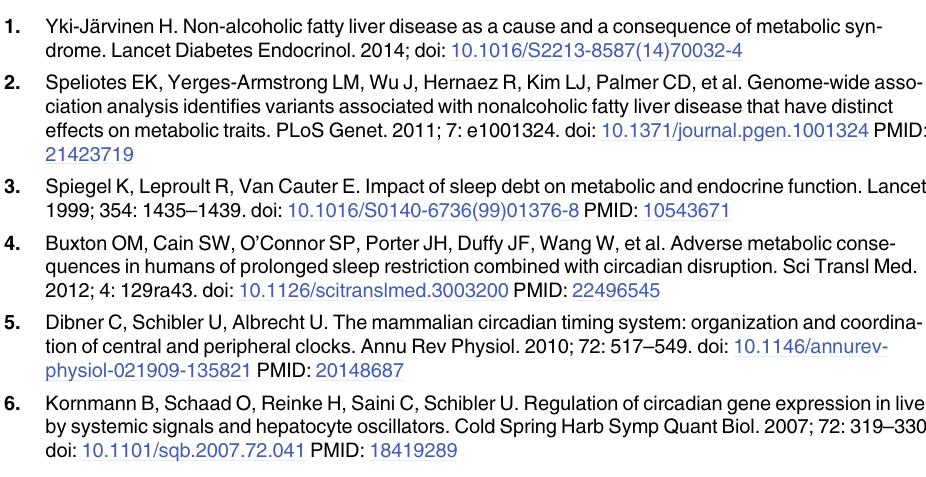
S2 Table. Biochemical parameters of Non-alcoholic fatty liver disease (NAFLD) patients and controls excluding subjects aged > 66 years. NAFLD patients n = 37 and controls n = 22. S3 Table. Sleep characteristics in patients with Non-alcoholic fatty liver disease (NAFLD) and controls excluding subjects aged > 66 years. NAFLD n = 37 (simple steatosis n = 11; NASH n = 26) and controls n = 22. Hours (h). Minutes (min.). Munich Chronotype Question- naire (MCTQ). Pittsburgh Sleep Quality Index (PSQI)). A score (cid:3) 5 is considered good sleep quality. Positive and negative affect scale (PANAS). Epworth Sleepiness scale (ESS). ESS score < 10 is considered normal. #, significant difference Control vs. NAFLD; ‡ , significant difference Controls vs. Steatosis; §, significant difference Control vs. NASH. S4 Table. Eating habits in NAFLD patients and controls. NAFLD (n = 44); Controls (n = 22). S5 Table. Daytime sleepiness is correlated with various biochemical parameters in non-cir- rhotic NAFLD patients. The subgroup of non-cirrhotic patients was analysed (n = 35). Oral glucose tolerance tests were done in all non-diabetic subjects (n = 27). Spearman correlations.